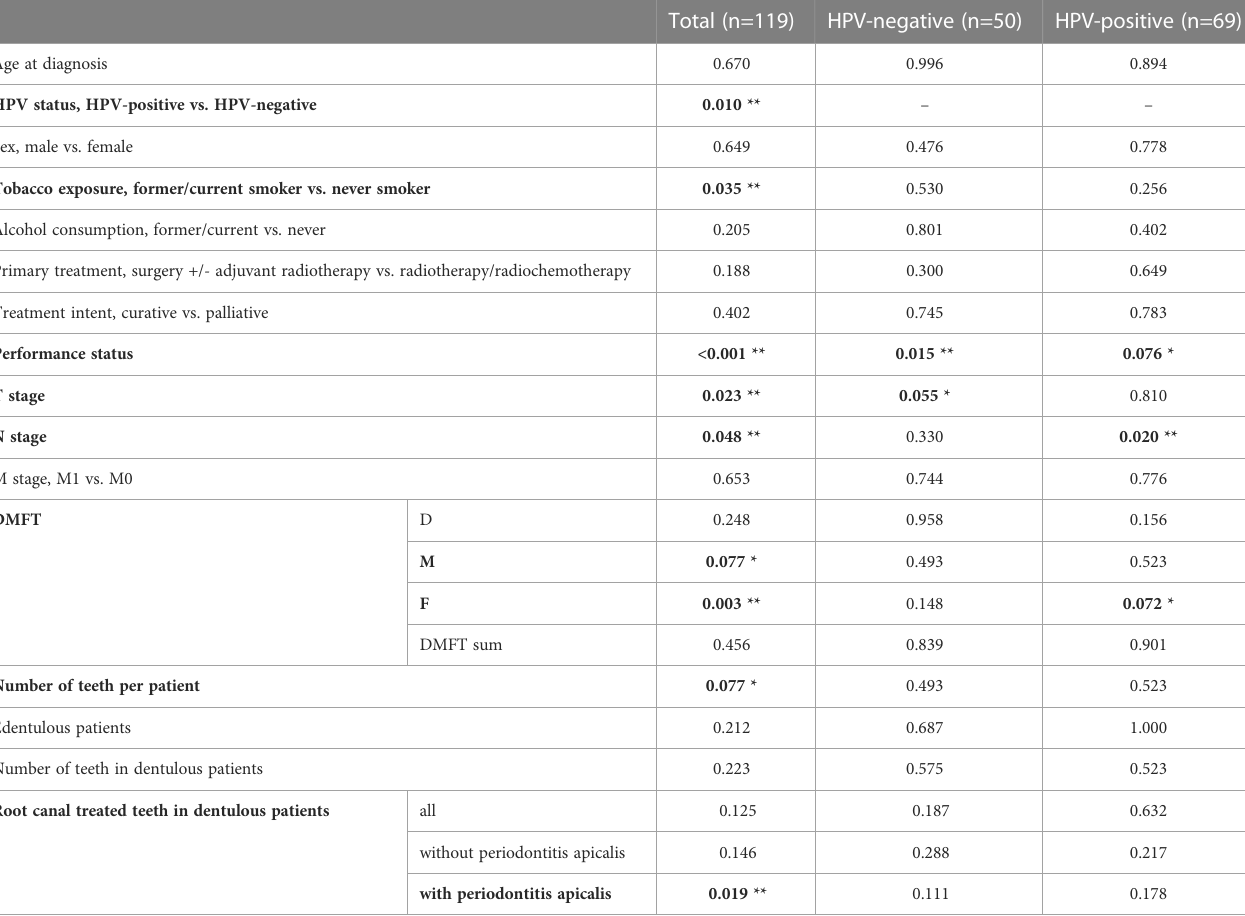
TABLE 2 Univariate effect (p-values) of patient-related risk factors for oropharyngeal squamous cell carcinoma, age, sex, and oral health parameters on survival.